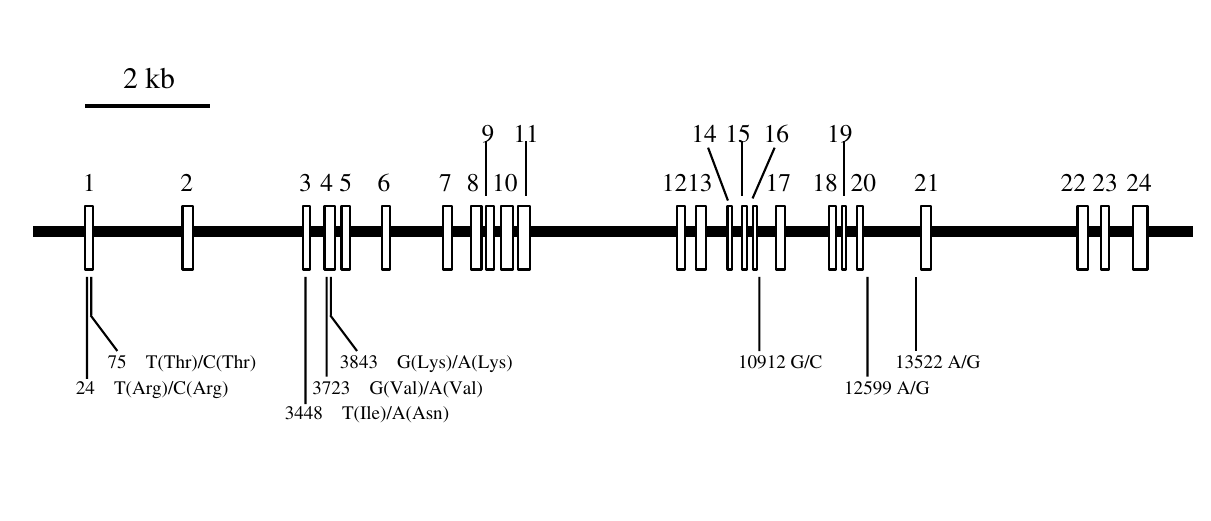
Figure 3 Relationship between genomic structure and the location of single-nucleotide polymorphisms (SNPs) in the IHRP